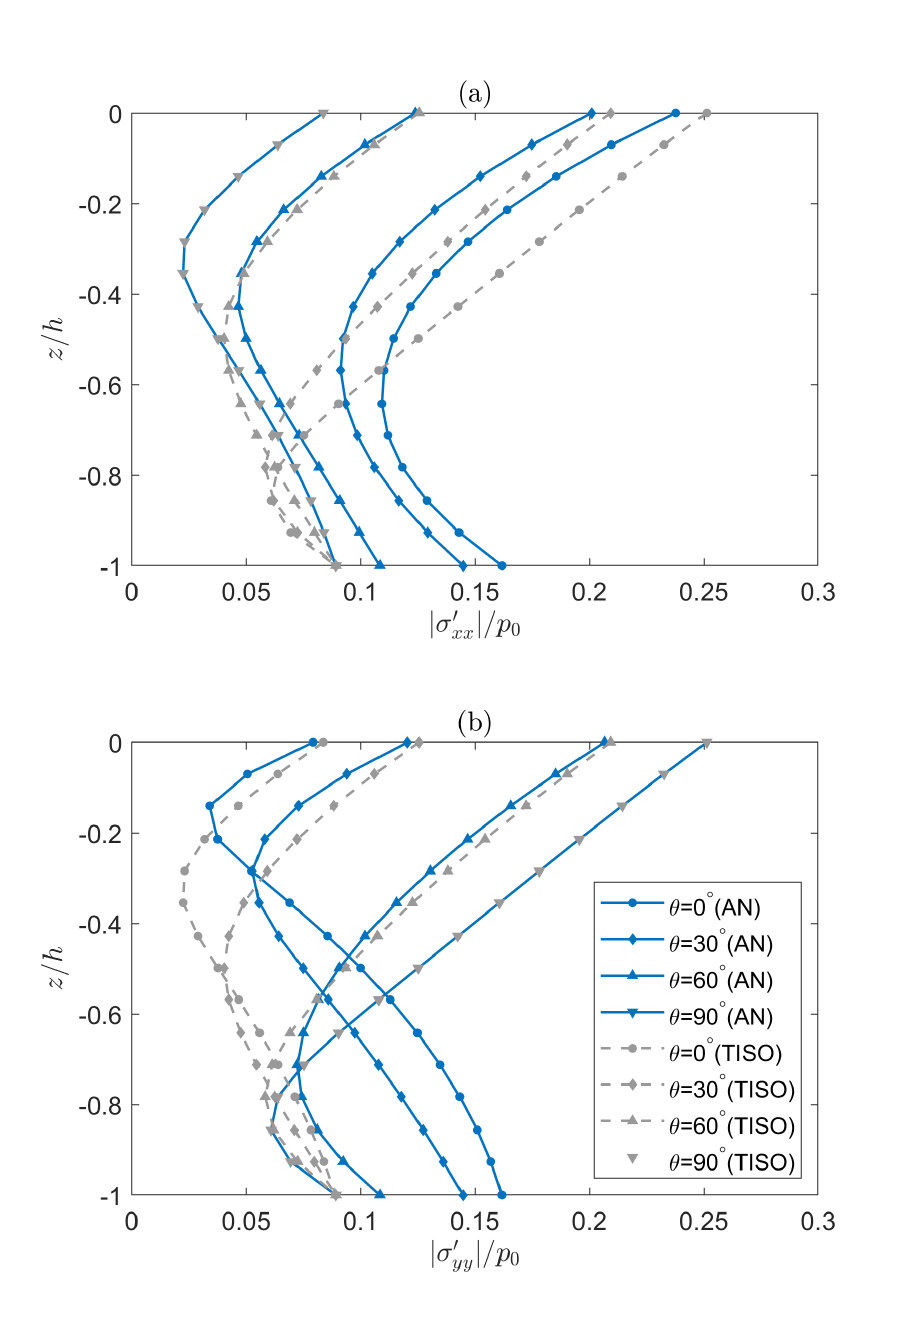
Figure 8. Comparison of horizontal effective stresses ( a ) σ (cid:48) xx and ( b ) σ (cid:48) yy for different wave directions between AN and TISO permeabilities (for the AN cases, θ = 0 ◦ ,30 ◦ ,60 ◦ , and 90 ◦ correspond respectively to Cases 4, 2, 5, and 6; for the TISO cases, θ = 0 ◦ ,30 ◦ ,60 ◦ , and 90 ◦ correspond respectively to Cases 7, 8, 9, and